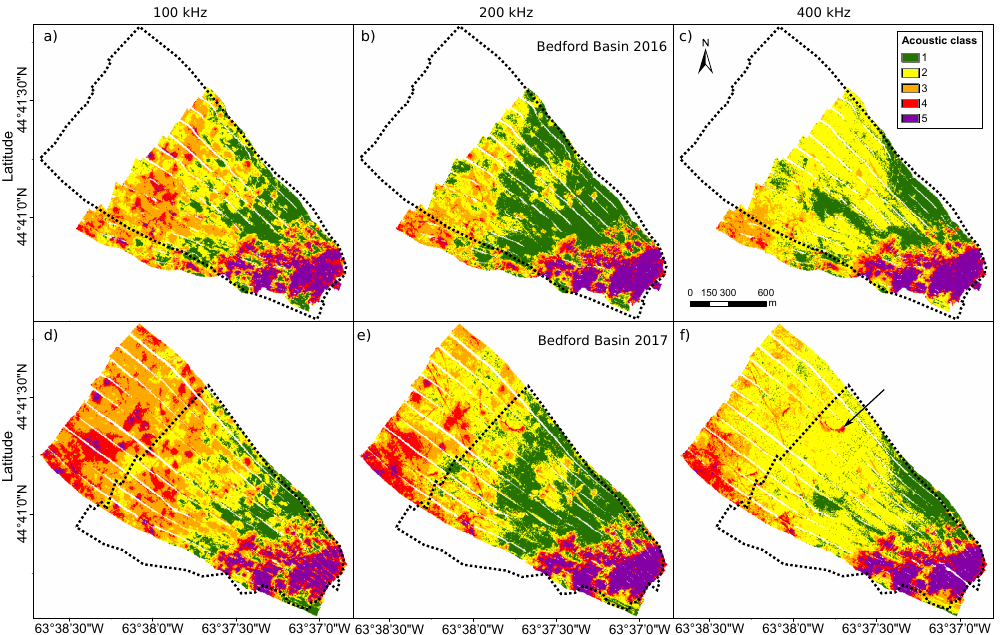
Figure 8. Acoustic classification maps of the Bedford Basin in 2016 and 2017 at ( a , d ) 100, ( b , e ) 200, and ( c , f ) 400 kHz. The spatial resolution is 5m by 5m. White spots indicate no data caused by neglected backscatter data at nadir. The arrow indicates a feature which is only present in the 200 and 400kHz AC maps of 2017. The dashed line represents the different survey